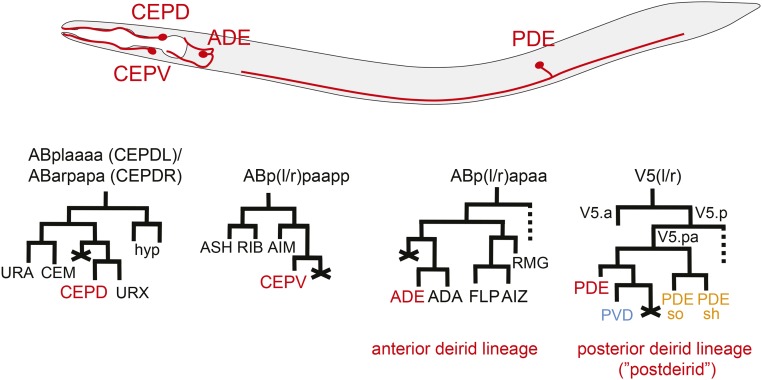
Dopaminergic neurons of the C. elegans hermaphrodite and their lineages. Lineage data comes from (Sulston and Horvitz 1977; Sulston et al. 1983). Dopaminergic neurons were first identified by Sulston et al. (1975). ADE, anterior deirid sensillum; CEP, cephalic sensillum; CEPD, dorsal CEP; CEPV, ventral CEP; PDE, postdeirid sensillum.